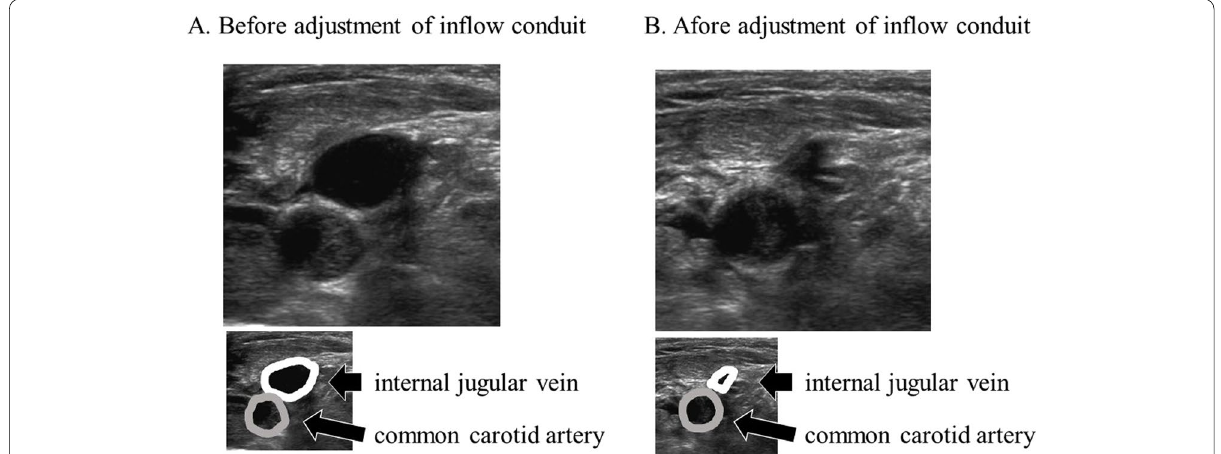
Fig. 2 Ultrasound image of the internal jugular vein. A Dilated internal jugular vein (IJV) during cardiopulmonary bypass with a venous cannula in the superior vena cava. B Collapsed IJV after repositioning the venous cannula. We confirmed IJV distension using compression by cervical echo. Before the devascularization was corrected, the IJV had a circular shape similar to that of an artery. In addition, the IJV did not collapse upon compression by the echo probe. After the devascularization position was corrected, the IJV easily collapsed under